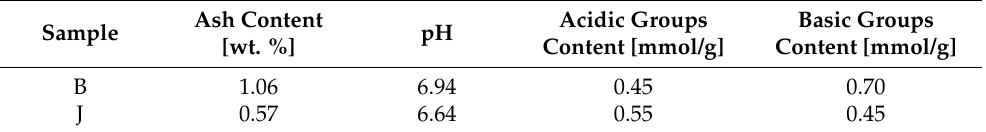
Table 2. Mineral matter (ash) contribution as well as acidic–basic properties of the carbonaceous materials derived from the used carbon